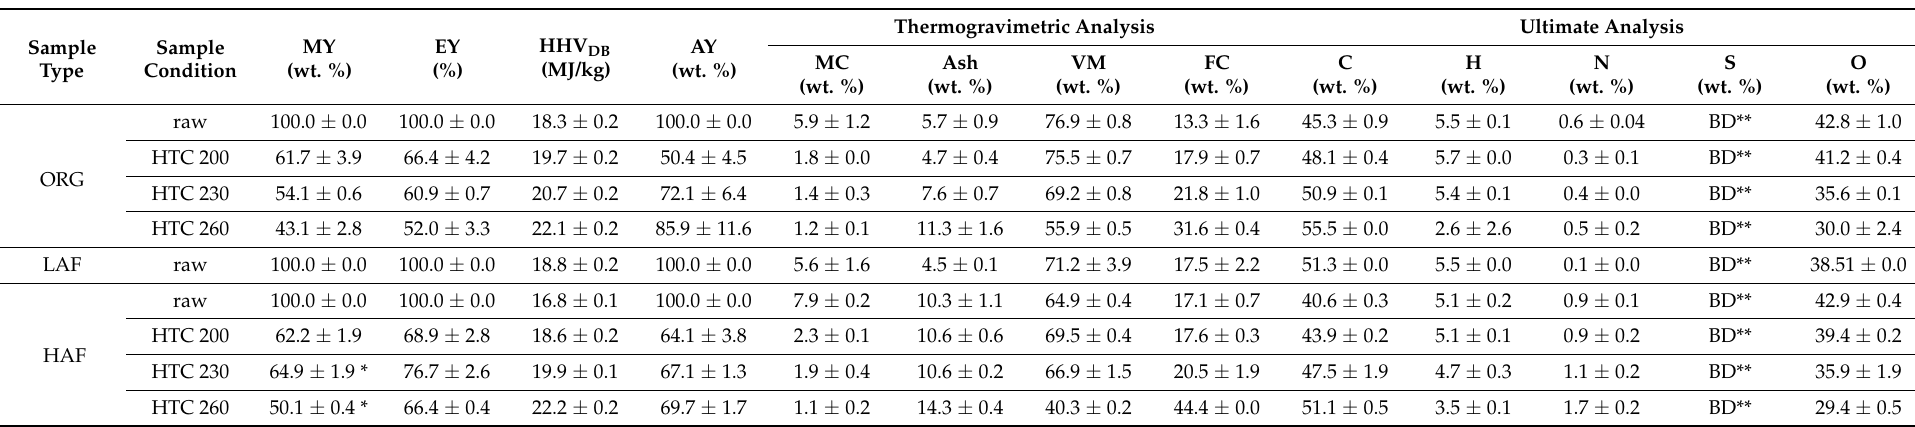
Table 2. Proximate and ultimate analysis of air classified CS hydrochars. DB is dry